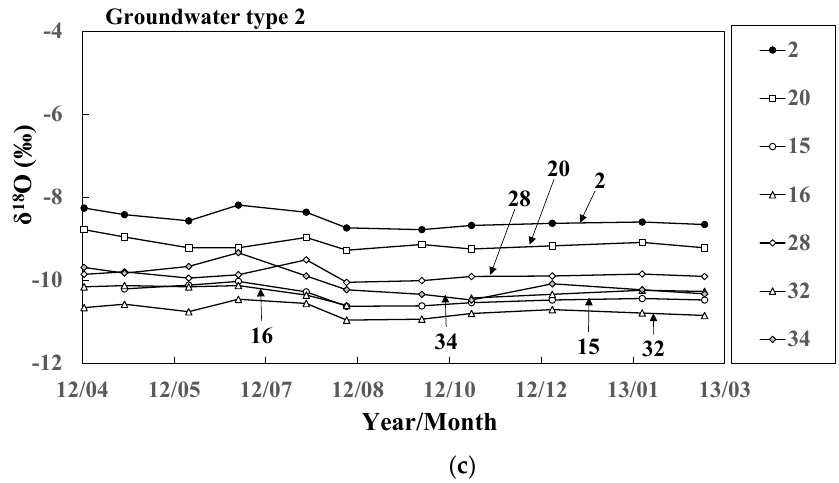
Figure 8. Seasonal variations of δ 18 O values for ( a ) river water and groundwater (( b ) Types 1 and ( c ) 2) at 11 representative sites.